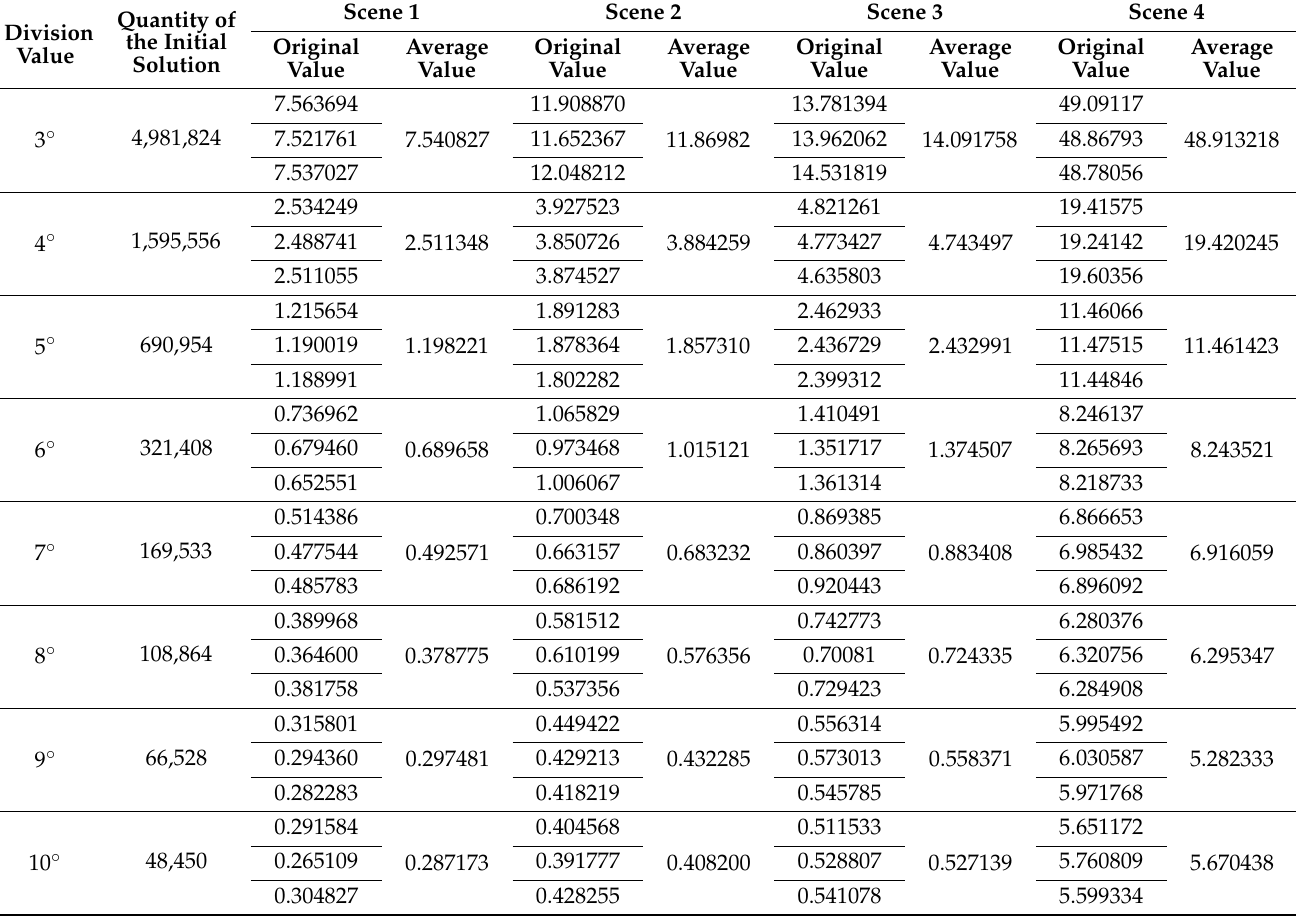
Table 7. Run Time (s) of Each Scene.